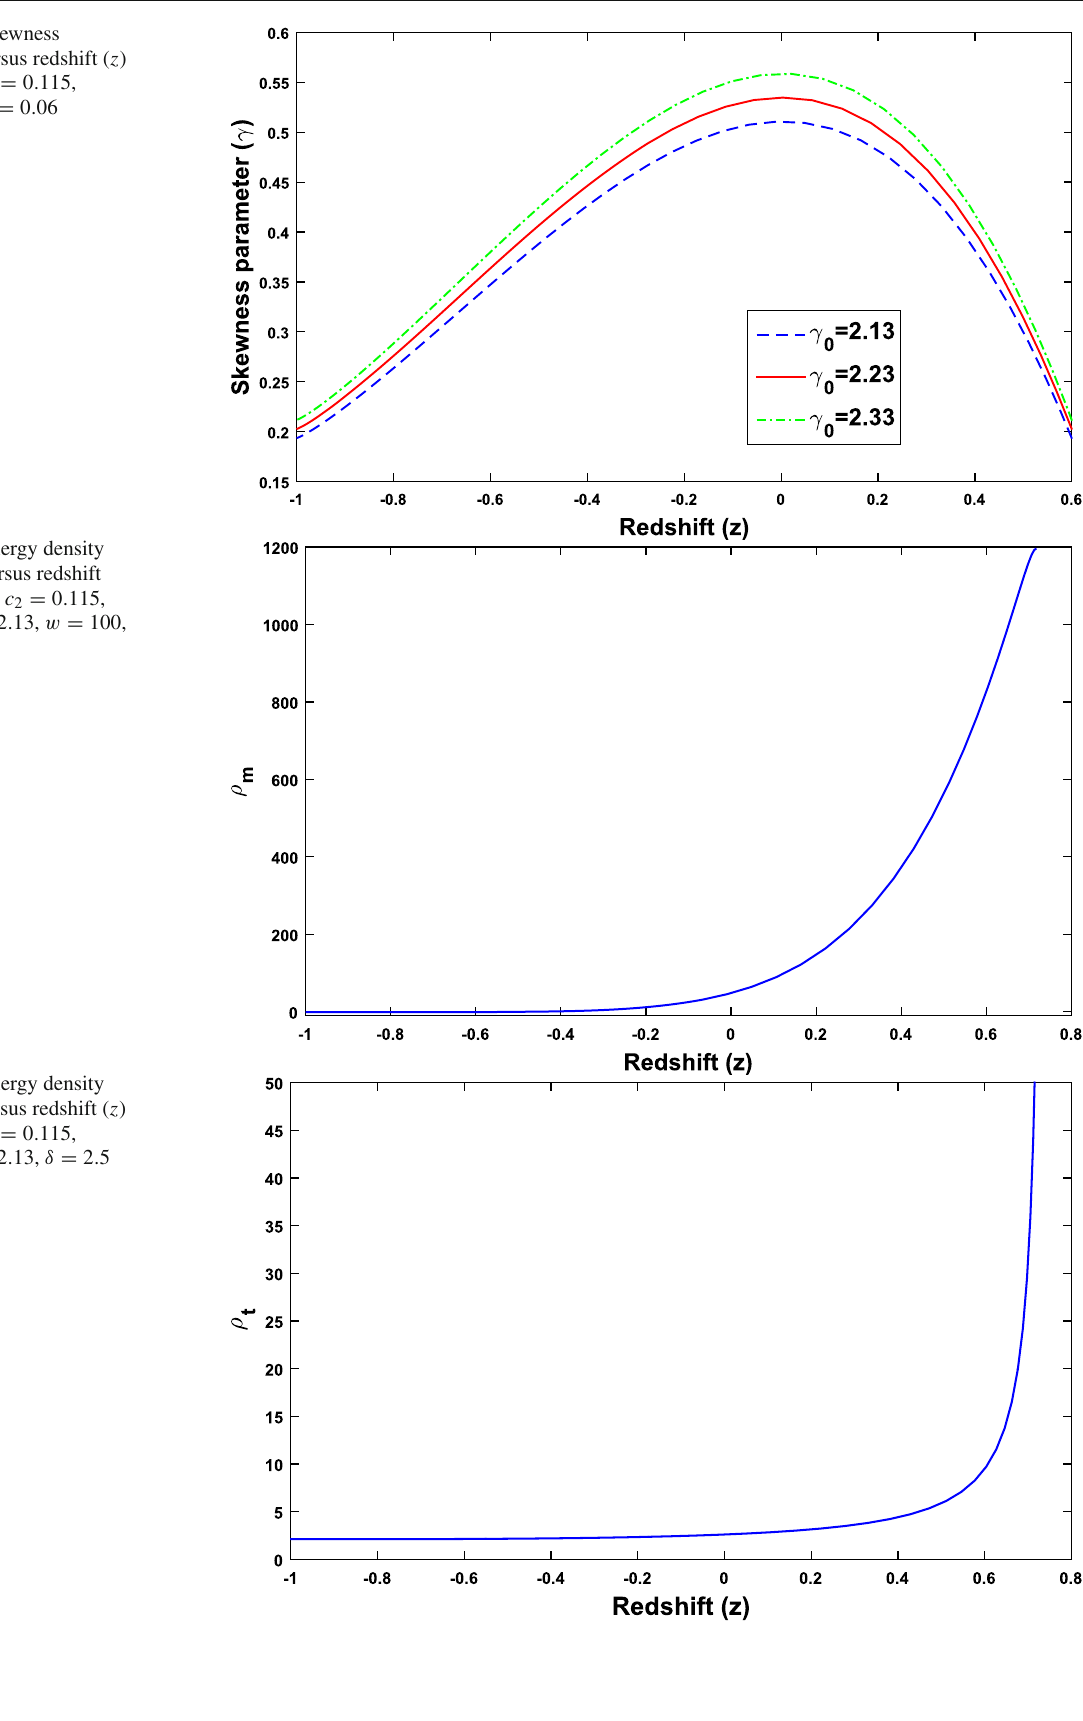
Fig. 2 Plot of energy density ( ρ m ) of matter versus redshift ( z ) for c 1 = 0 . 01, c 2 = 0 . 115, k = 0 . 325, γ 0 = 2 . 13, w = 100, and φ 0 = 1